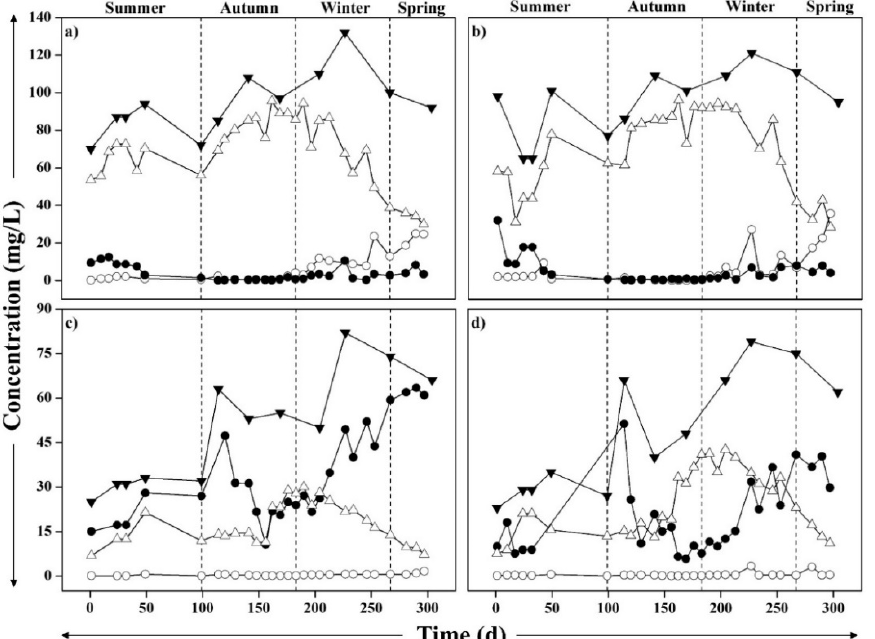
Figure 5. Concentrations of different forms of nitrogen (mg/L) NO 2 − -N ( ○ ), NO 3 − -N ( ● ), NH 4+ -N ( △ ) and TN ( ▼ ): ( a ) VSSF 1; ( b ) VSSF 2; ( c ) HSSF 1; and ( d ) HSSF 2.